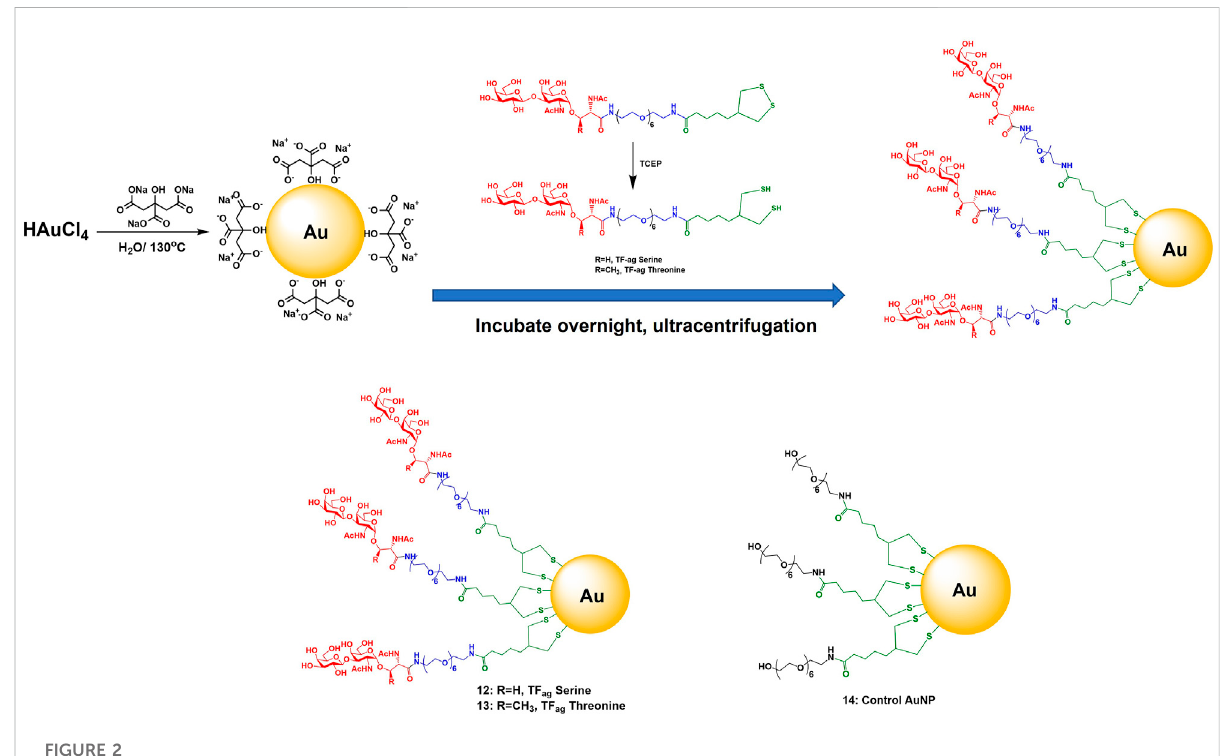
FIGURE 2 Synthesis of AuNPs prepared in this work and structure of AuNPs 12 – 14